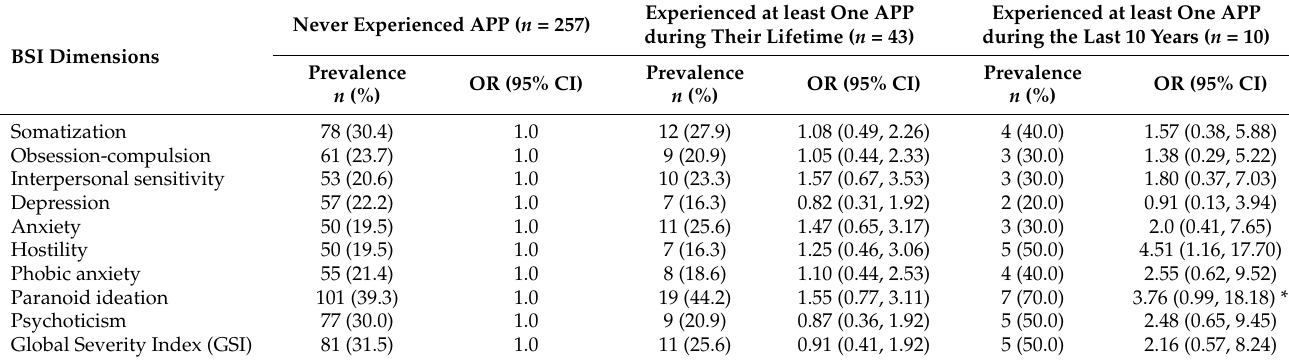
Table 4. Prevalence and odds of cases of mental health according to normalized T-scores on the Brief Symptom Inventory (BSI) (cutoff T-score ≥ 63) in the study